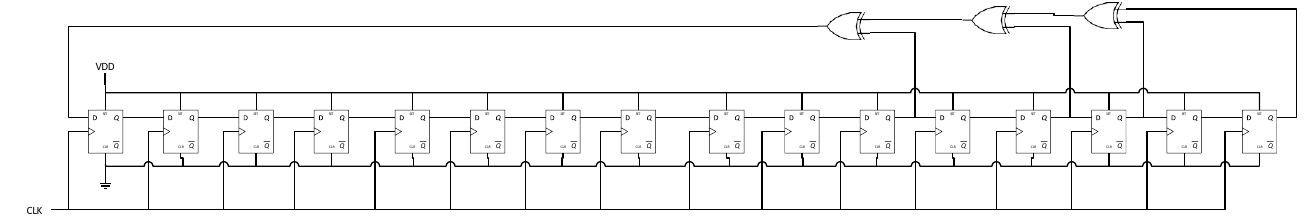
Figure 12. 16-bit Fibonacci LFSR where CLK is the clock signal.